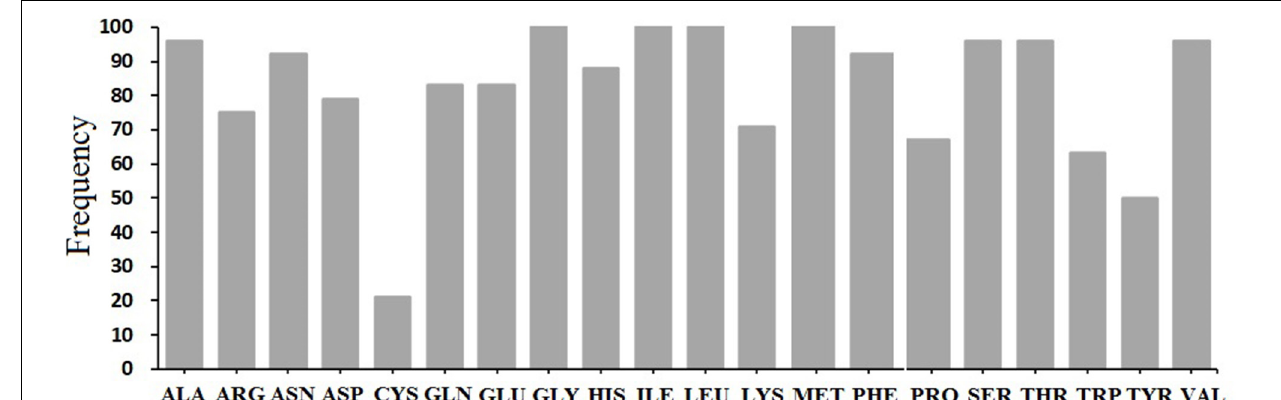
FIGURE 6 | Distribution of ligand-binding sites in all studied MTP